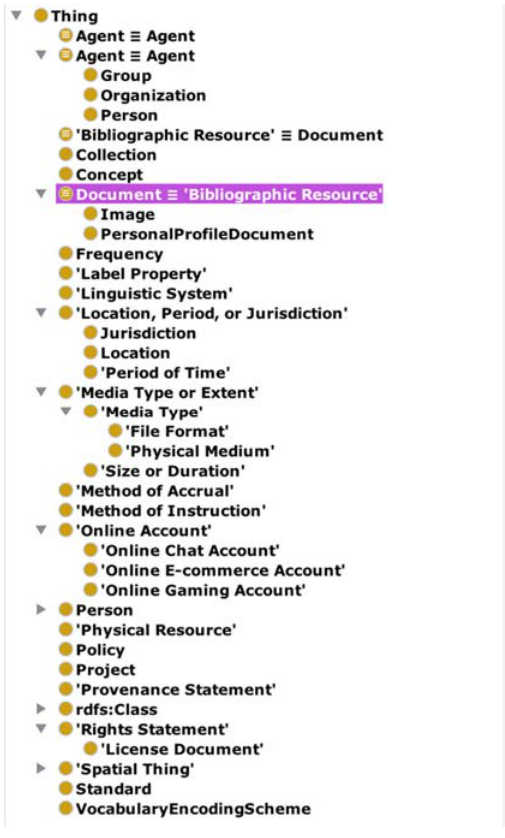
Figure 5. Class hierarchy of the merged ontology.